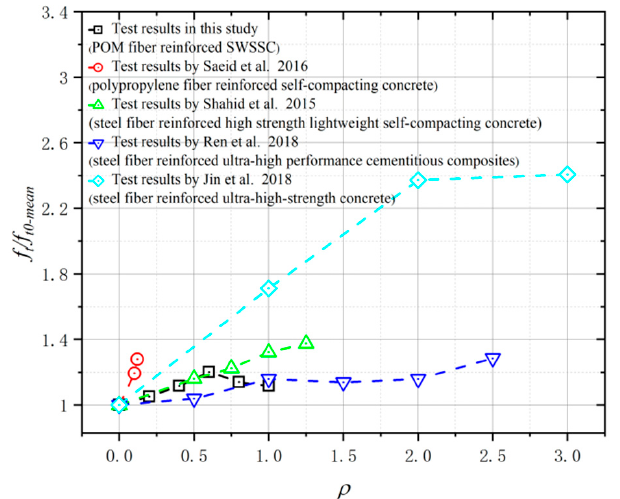
Figure 19. Comparison of tensile strength between POM-SWSSC and other types of fiber-reinforced concrete [58–61].